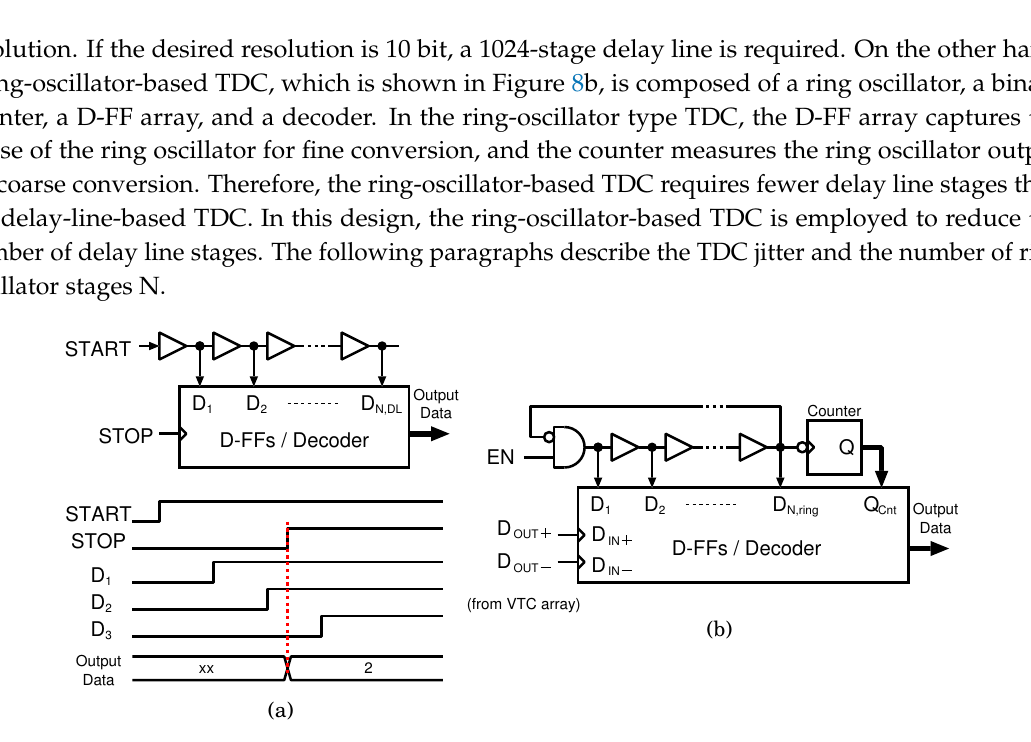
Figure 8. Block diagram of ( a ) delay-line-based TDC, and ( b ) ring-oscillator-based